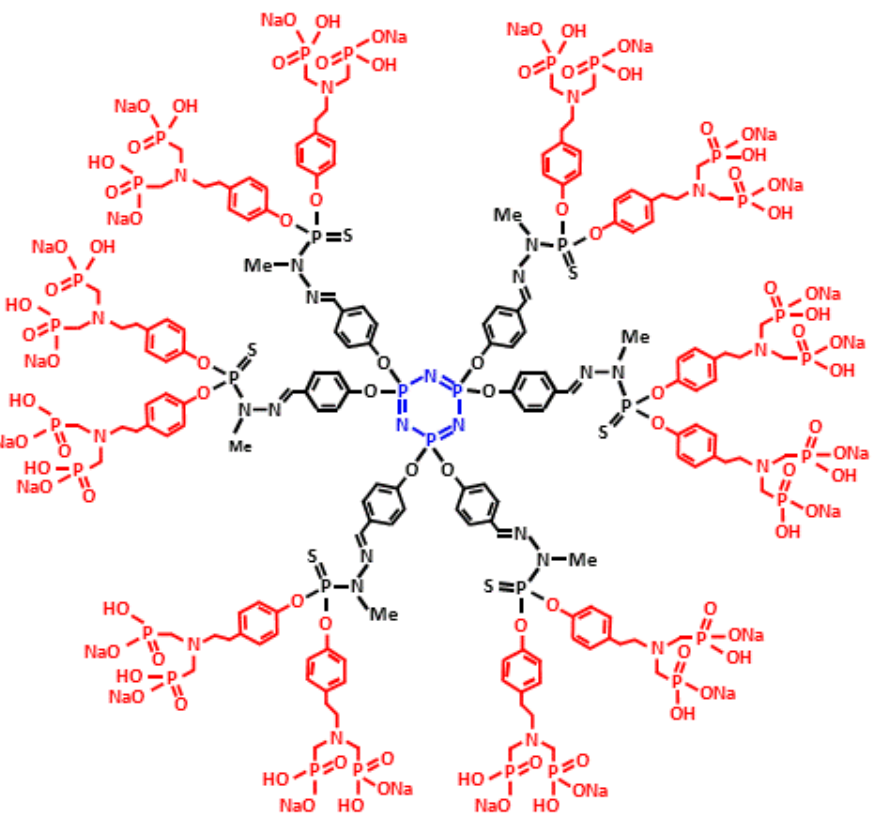
FIGURE 3. Structure of the phosphorus-containing dendrimer ABP used in Fruchon et al.[46]. In blue, the cyclo-triphosphazene (N methylhydrazone branches; in red, the tyramine-based ABP surface